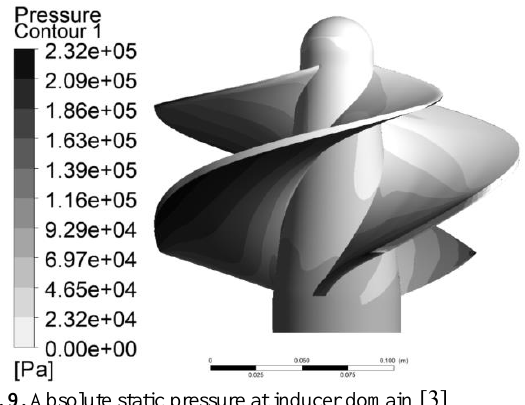
Fig. 9. Absolute static pressure at inducer domain [3]